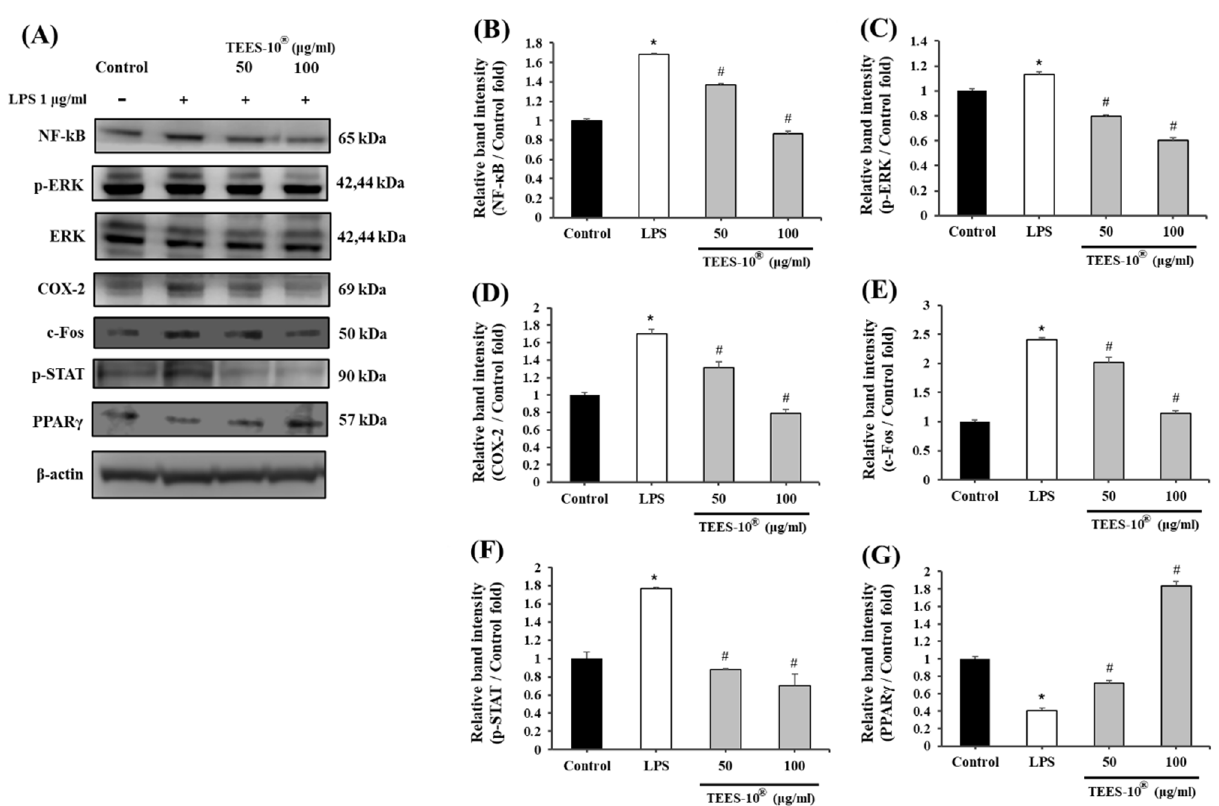
Figure 5. Effects of TEES-10 ® on NF- κ B, p-ERK, ERK, COX-2, c-Fos, p-STAT and PPAR γ expression in LPS-treated PDL cells by western blot analysis. ( A ) Protein expression bands of NF- κ B, p-ERK, ERK, COX-2, c-Fos, p-STAT and PPAR γ . ( B ) Graphs represent relative band intensity of NF- κ B compared with β -actin band intensity. ( C ) Graphs represent relative band intensity of p-ERK compared with β -actin band intensity. ( D ) Graphs represent relative band intensity of COX-2 compared with β -actin band intensity. ( E ) Graphs represent relative band intensity of c-Fos compared with β -actin band intensity. ( F ) Graphs represent relative band intensity of p-STAT compared with β -actin band intensity. ( G ) Graphs represent relative band intensity of PPAR γ compared with β -actin band intensity. Each bar represents the mean ± SEM ( n = 3). * p < 0.05 compared with the control group. # p < 0.05 compared with the 1 μ M LPS-treated group.